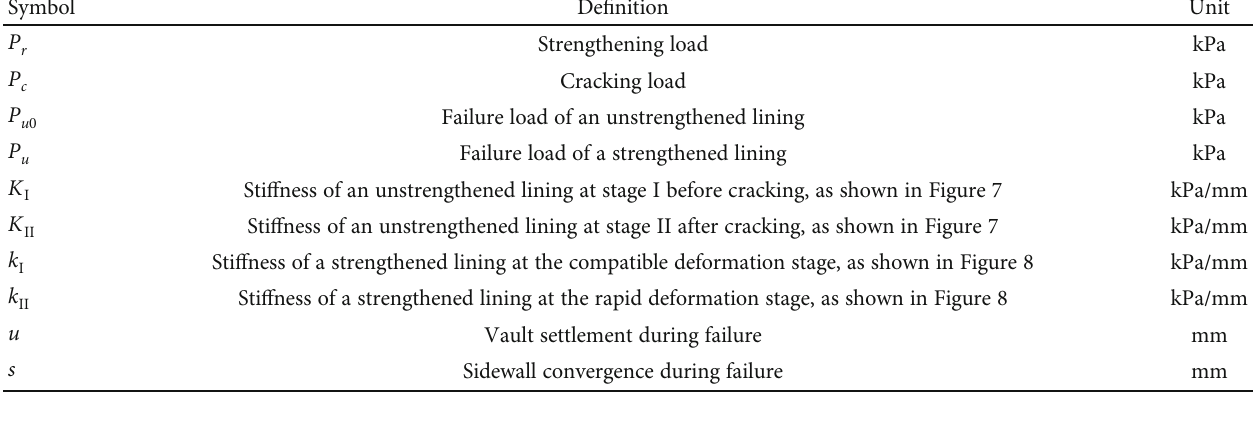
Table 2: De fi nitions of several physical quantities used in the paper.